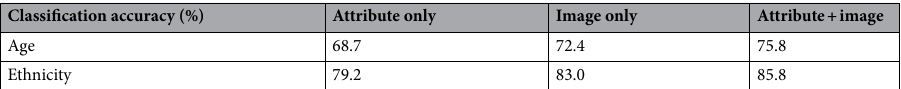
Table 6. Ablation studies of the attribute learning module and using images as additional inputs in the demographics prediction model. The proposed model with both attribute learning model and images as additional inputs leads to the highest prediction accuracy. For age and ethnicity classification, removing either the attribute module or the image as additional input leads to decreased classification accuracy.